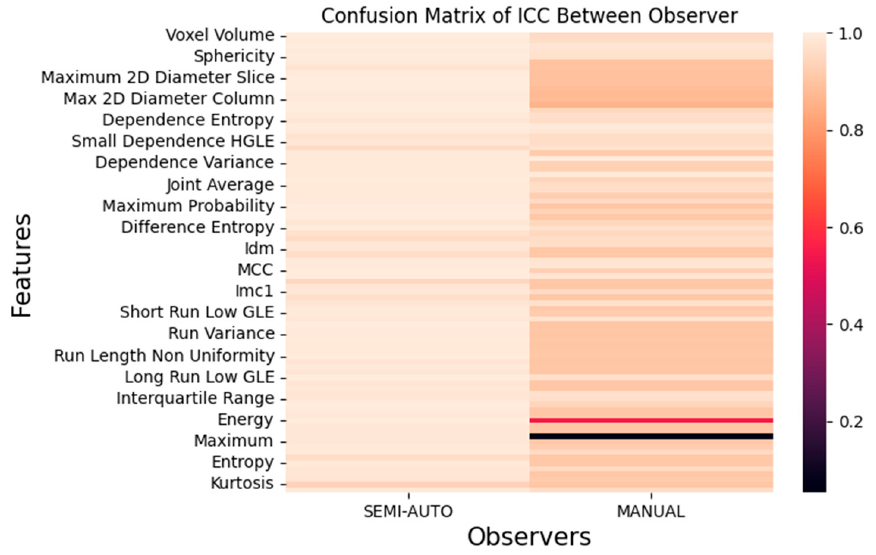
Figure 6. Intra-class correlation coefficient (ICC) value comparisons for first order statistical charac- teristics for ( p < 0.05).